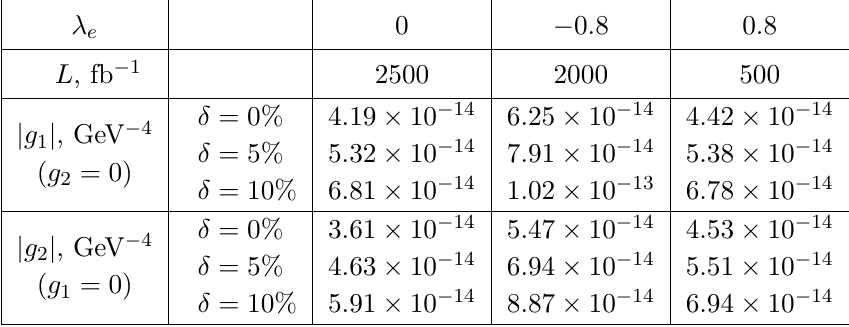
Table 1 . The 95% C.L. exclusion limits on the anomalous quartic couplings g 1 and g 2 for the √ collision energy s = 1500 GeV, and the cut m γZ > 1000